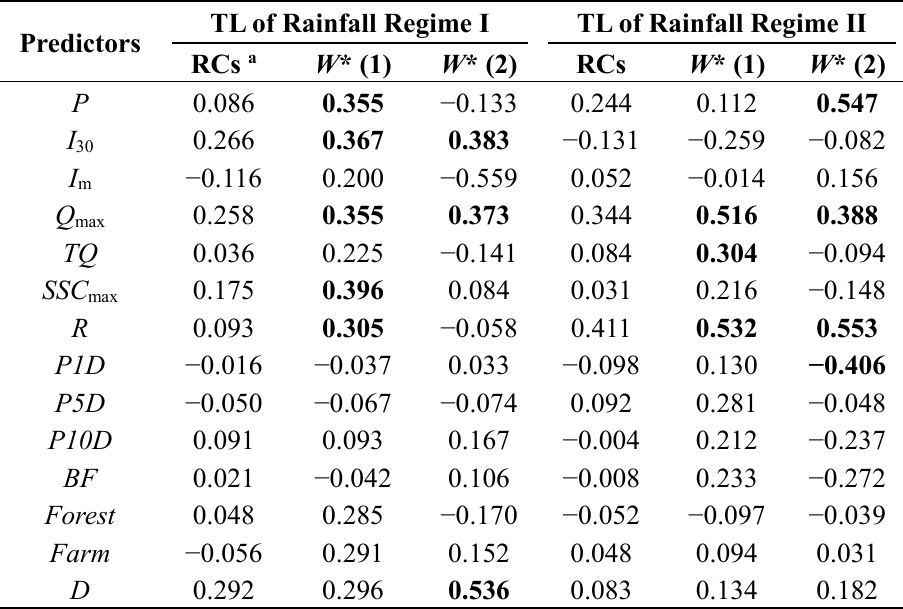
Table 7. PLSR for sediment